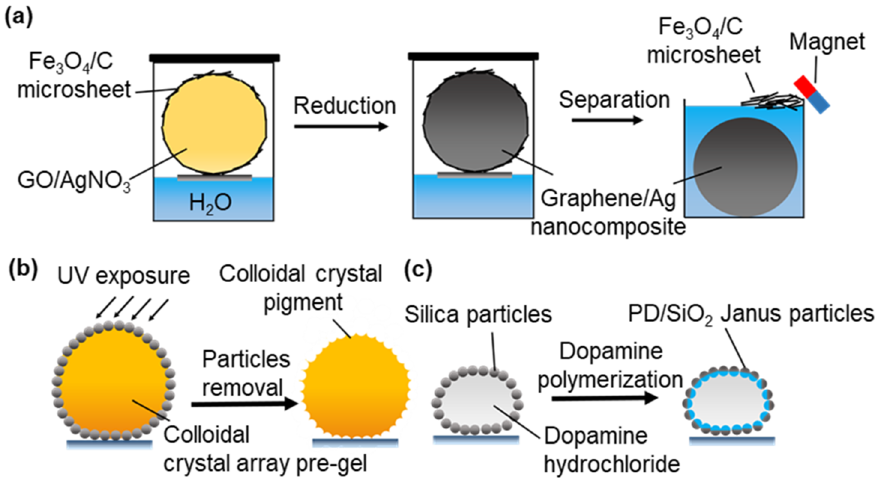
Figure 4. Solid material synthesis in liquid marble-based microreactors. ( a ) Synthesis of graphene/Ag nanocomposite [50] . ( b ) Synthesis of colour pigment [62] . ( c ) Synthesis of polydopamine/silica Janus particles in liquid marble reactors [63].